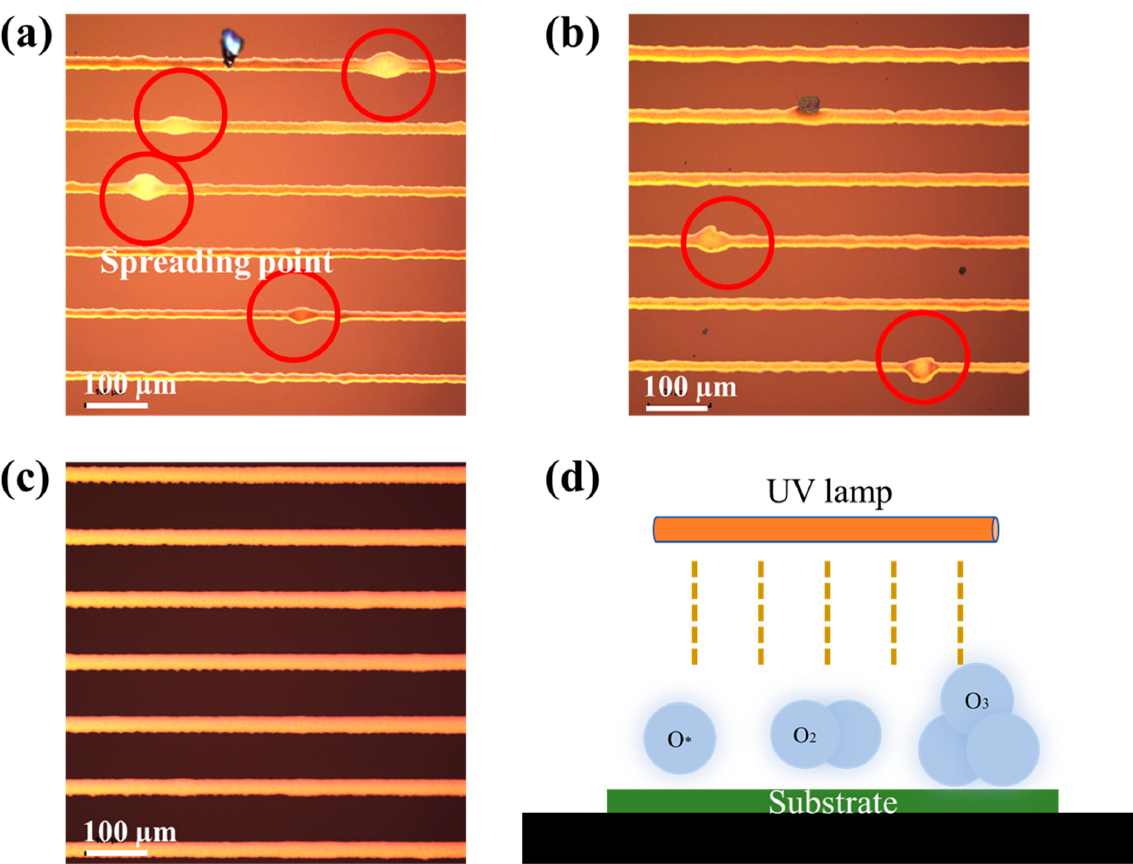
Figure 2. Microscopic pictures of the printed line: ( a ) untreated; ( b ) after UV treatment for 10 min; ( c ) after oxygen-plasma treatment for 10 min; ( d ) schematic diagram of oxygen-plasma treatment.